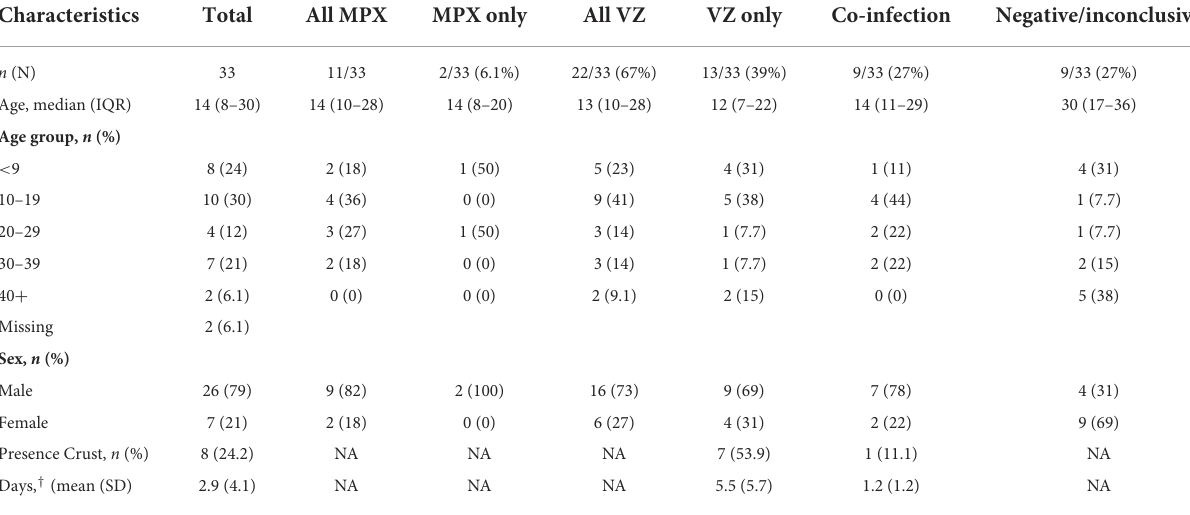
TABLE 1 Patient demographic and clinical characteristics in all case series. Characteristics